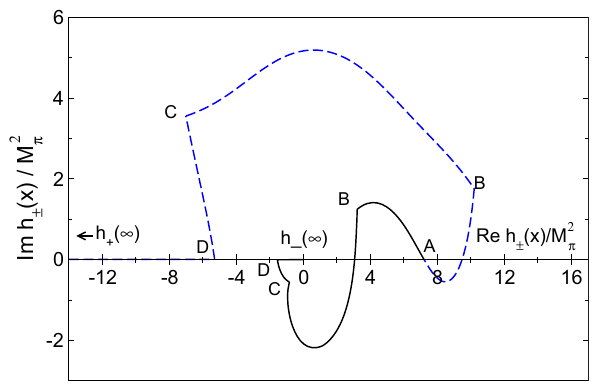
Fig. 5 Real and imaginary part of the endpoints h ± ( x ) in (7), if the integrationinthedispersiveintegral(2)isperformedalongthedeformed pathABCDEFinFig.1.ComparewithFig.2,whichshowsthesituation in the standard case